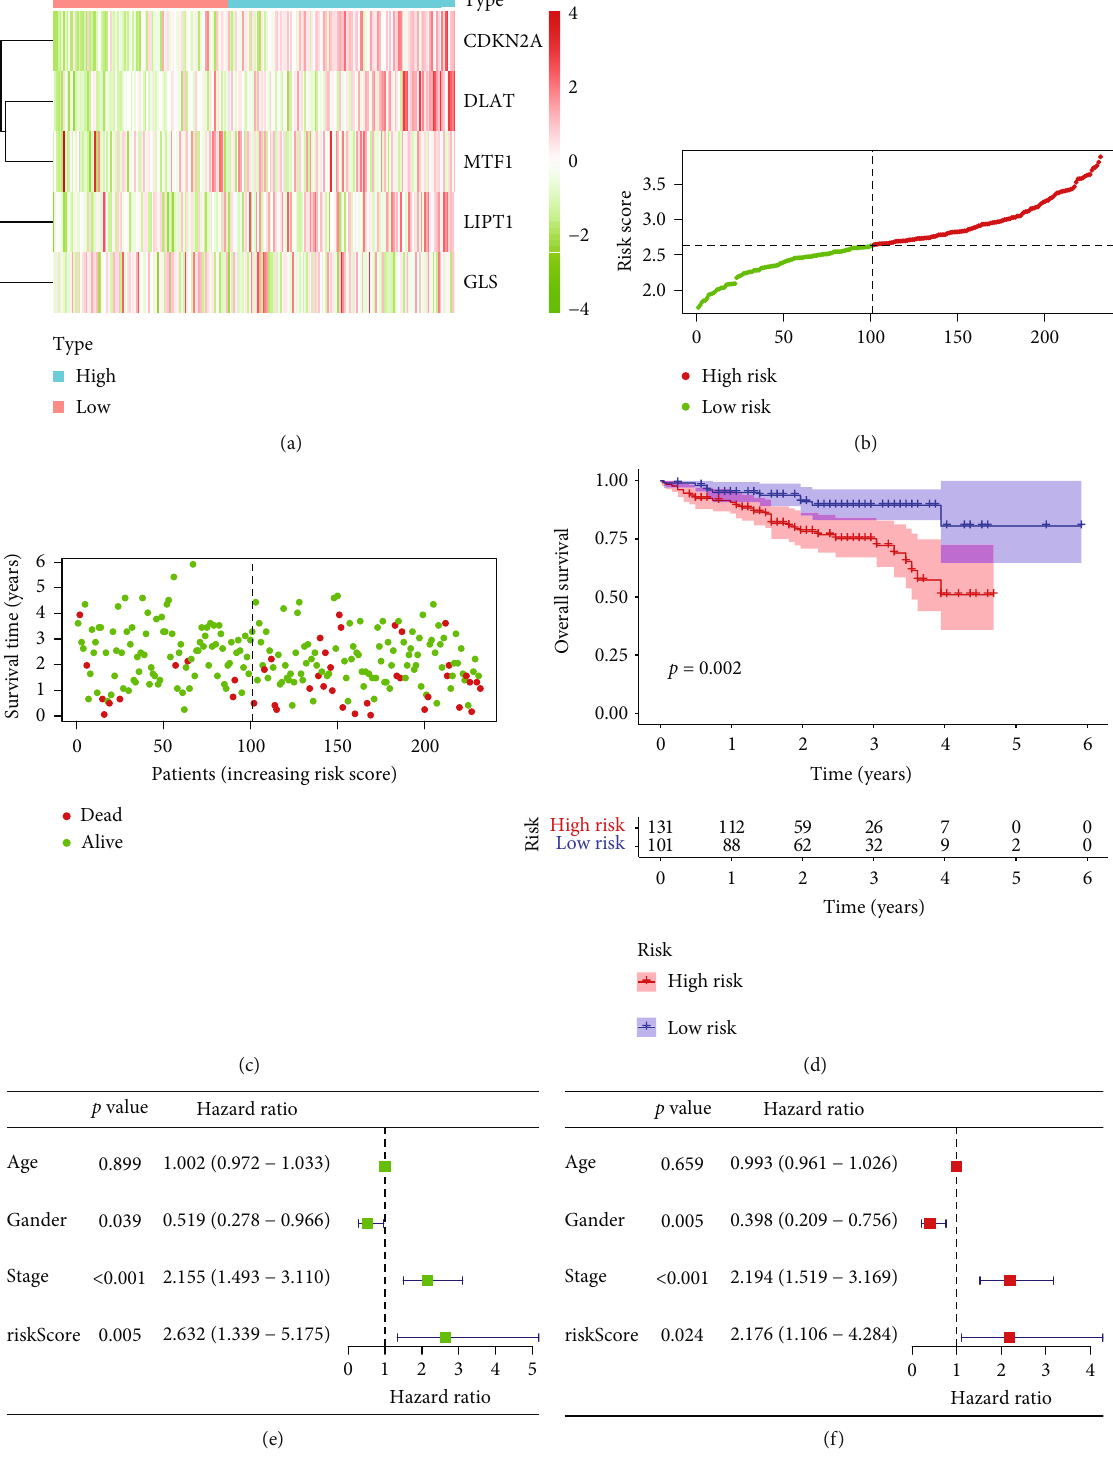
Figure 9: Veri fi cation of the fi ve CRGs signature in the ICGC cohort. (a) Heatmaps of fi ve prognostic CRGs in the ICGC database according to the risk score distribution. The color legend represents the log2 (FPKM) value. (b) The risk scores distribution. (c) The survival status of each patient is according to the risk score distribution. (d) Kaplan-Meier curves for the OS of HCC patients. (e, f) The independent survival analysis of the risk scores and clinical traits through univariate and multivariate Cox regression